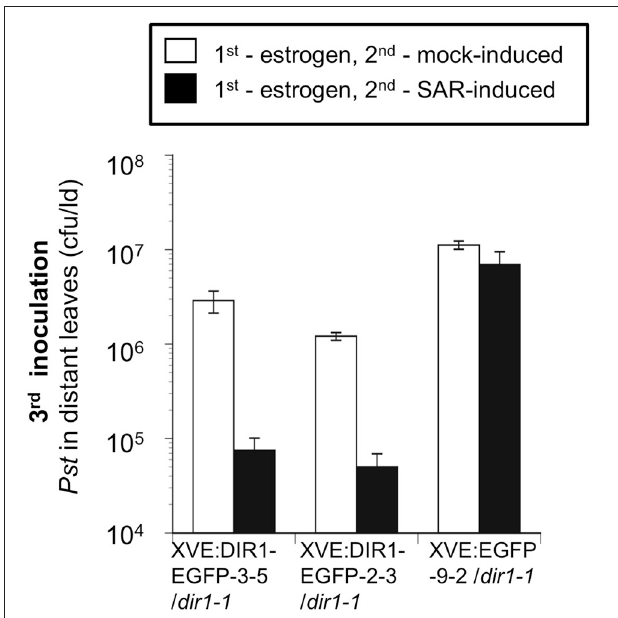
FIGURE 8 | SAR Assays using estrogen-inducible lines. EGFP and DIR1-EGFP expression was induced in XVE:DIR1-EGFP/ dir1-1 l(3–5 and 2–3) and XVE:EGFP-9-2/ dir1-1 by infiltrating two lower leaves with estrogen, followed 14–24h later by a second inoculation to mock- or SAR-induce ( Pst-avrRpt2 ) the same leaves. A third inoculation in distant leaves with virulent Pst was used to assay for SAR. This experiment was repeated three additional times with similar results.